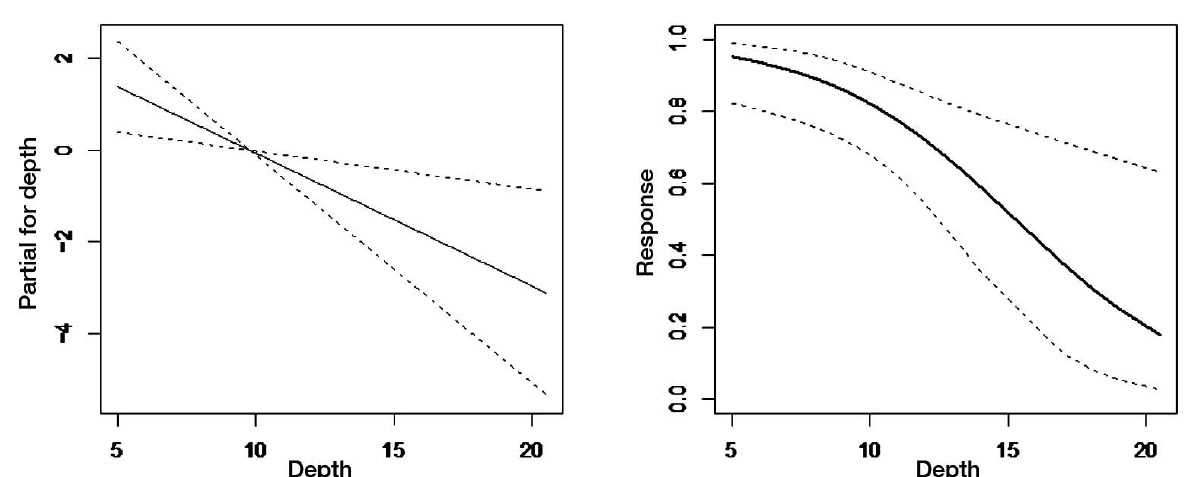
Fig. 3. – Left panel: partial effect (solid line) with the 95% confidence interval (broken lines) of the covariate depth on the presence/absence of O. vulgaris in dens. The results are reported on the scale of the linear predictor. Right panel: prediction of the probability of den occupancy of O. vulgaris .